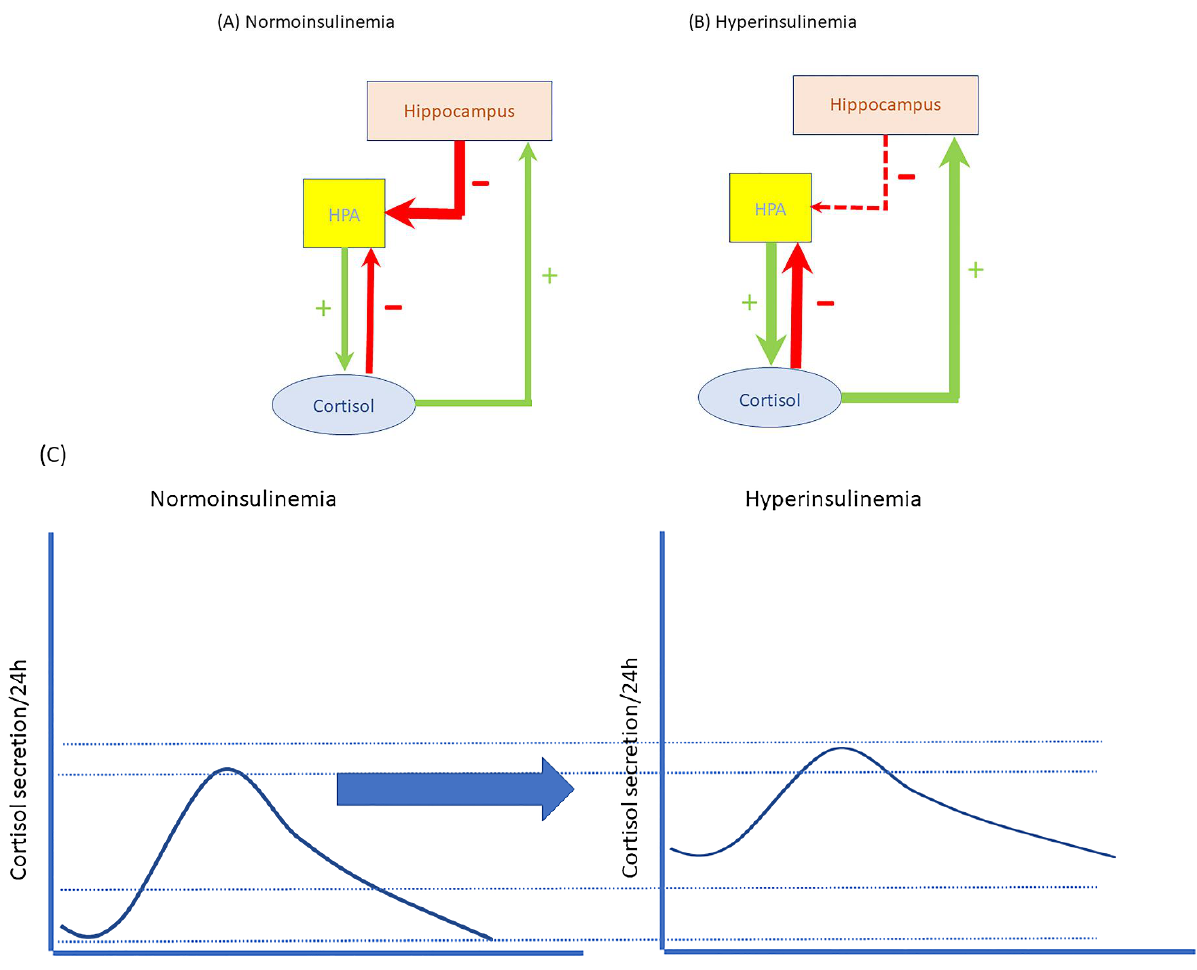
Figure 6. Insulin can cross the blood brain barrier and exert direct effects at the hippocampus. In normoinsulinemic conditions, the hippocampus has inhibitory control over the HPA axis preventing excess cortisol release. Cortisol in turn has negative feedback on the HPA activity and positive feedback on the hippocampus ( A ). In hyperinsulinemic conditions the inhibitory activity of the hippocampus on the HPA axis is decreased (releases “the brake”). Consequently, the homeostatic setpoint (the predetermined level) of the HPA axis activity will change: cortisol secretion per 24 h increases (compared to normoinsulinemic conditions) and thereby induces a state of “functional hypercortisolism” ( B ). The exaggerated cortisol secretion per 24 h during hyperinsulinemia can be explained by increased forward drive to the HPA axis, and/or reduced sensitivity of the HPA axis to negative feedback by cortisol ( C ). Stimulatory effects are shown in green and inhibitory effects are shown in red. See text for more details. Both birth and infant weights have been found to be inversely associated with the prevalence of impaired glucose tolerance, the metabolic syndrome, type 2 diabetes, and polycystic ovary syndrome later in life [86]. In addition, it has become clear that intra- uterine environment may also have long-lasting and permanent effects on the activity of the HPA axis [87 – 89]. Urinary excretion of total glucocorticoid metabolites in a population sample of 9-year-old children was higher in children who had a low birthweight [87]. In a study in 60- to 70-year-old men, fasting plasma cortisol concentrations were inversely related to birth weight and body mass index [88]. Furthermore, it was shown that pituitary and adrenal progenitor cells exposed to hyperinsulinemia are metabolically primed to a hyper-functional state of the HPA axis and enhanced cortisol production later in life [89]. This latter mechanism might explain how hyperinsulinemia early in life increases the risk for developing the metabolic syndrome in adulthood [89]. 11. HPA Activity in Obesity and the Metabolic Syndrome Earlier studies proved that the total daily cortisol production rate is somewhat en- hanced in obesity and the metabolic syndrome [90 – 93]. This is further supported by data showing that the HPA axis responsiveness in obesity, particularly when there was visceral obesity, was enhanced to stimuli such as acute stress, hypoglycemia, a standard meal, or CRH/arginine vasopressin [83,91,94]. In addition, ACTH hyper-responsiveness after